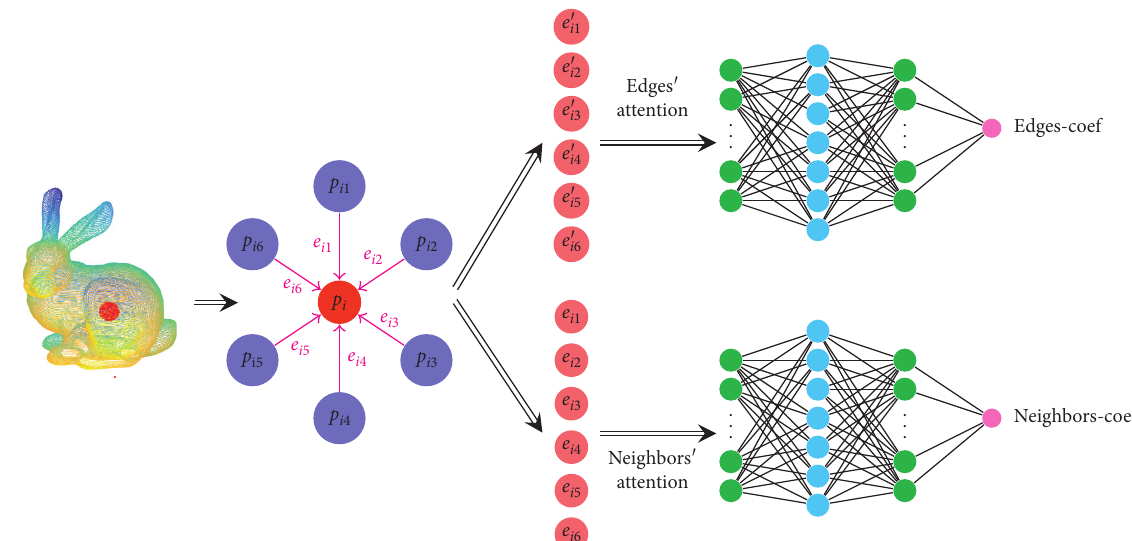
p ,p , p , p ,p , p 􏼈 􏼉 are a central point and its neighbors, respectively. The directed edges i and i 1 i 2 i 3 i 4 i 5 i 6 , e ,e ,e , e ,e 􏼈 􏼉 . i 2 i 3 i 4 i 5 i 6 1